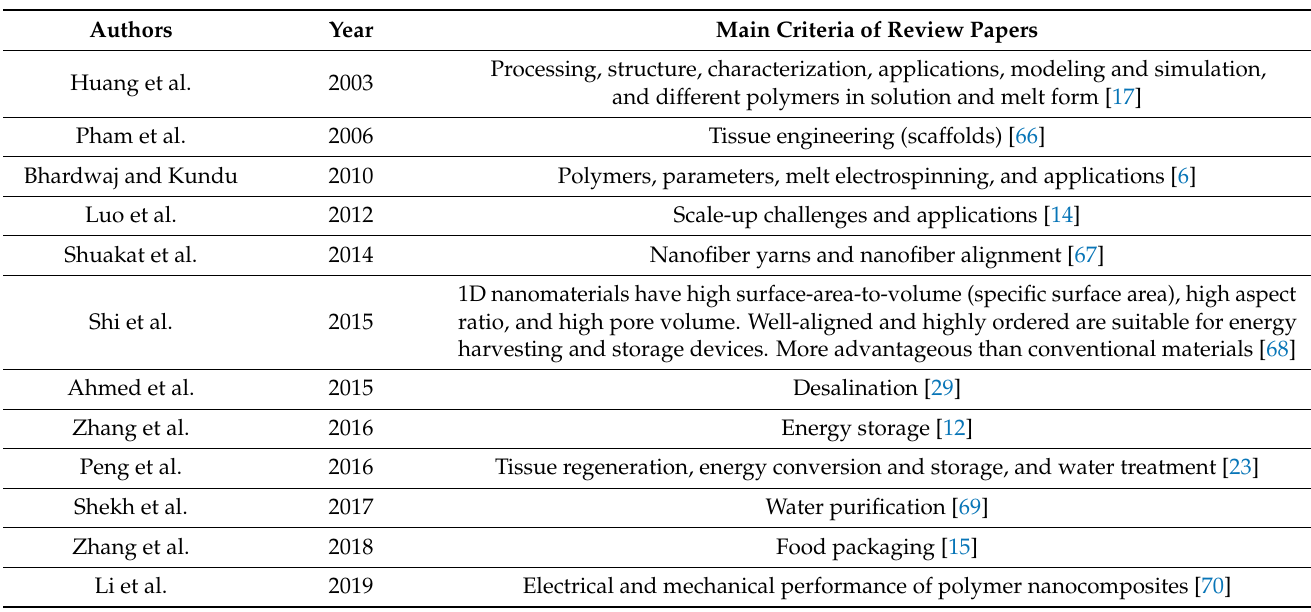
Table 1. Recent review papers on electrospun